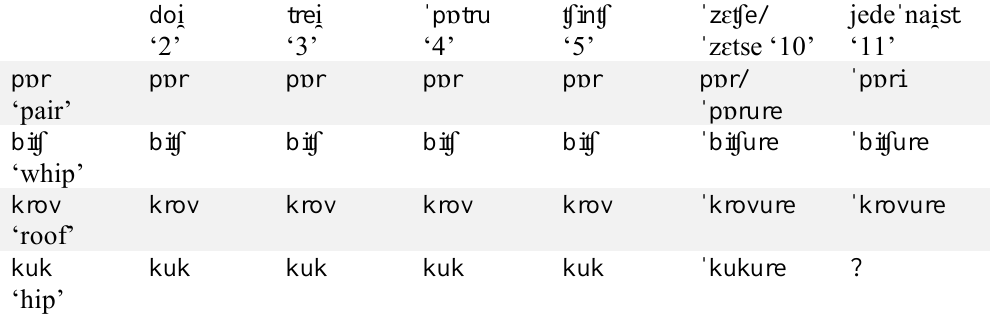
Table 14. Marking of the ‘ten’ threshold by -ure in